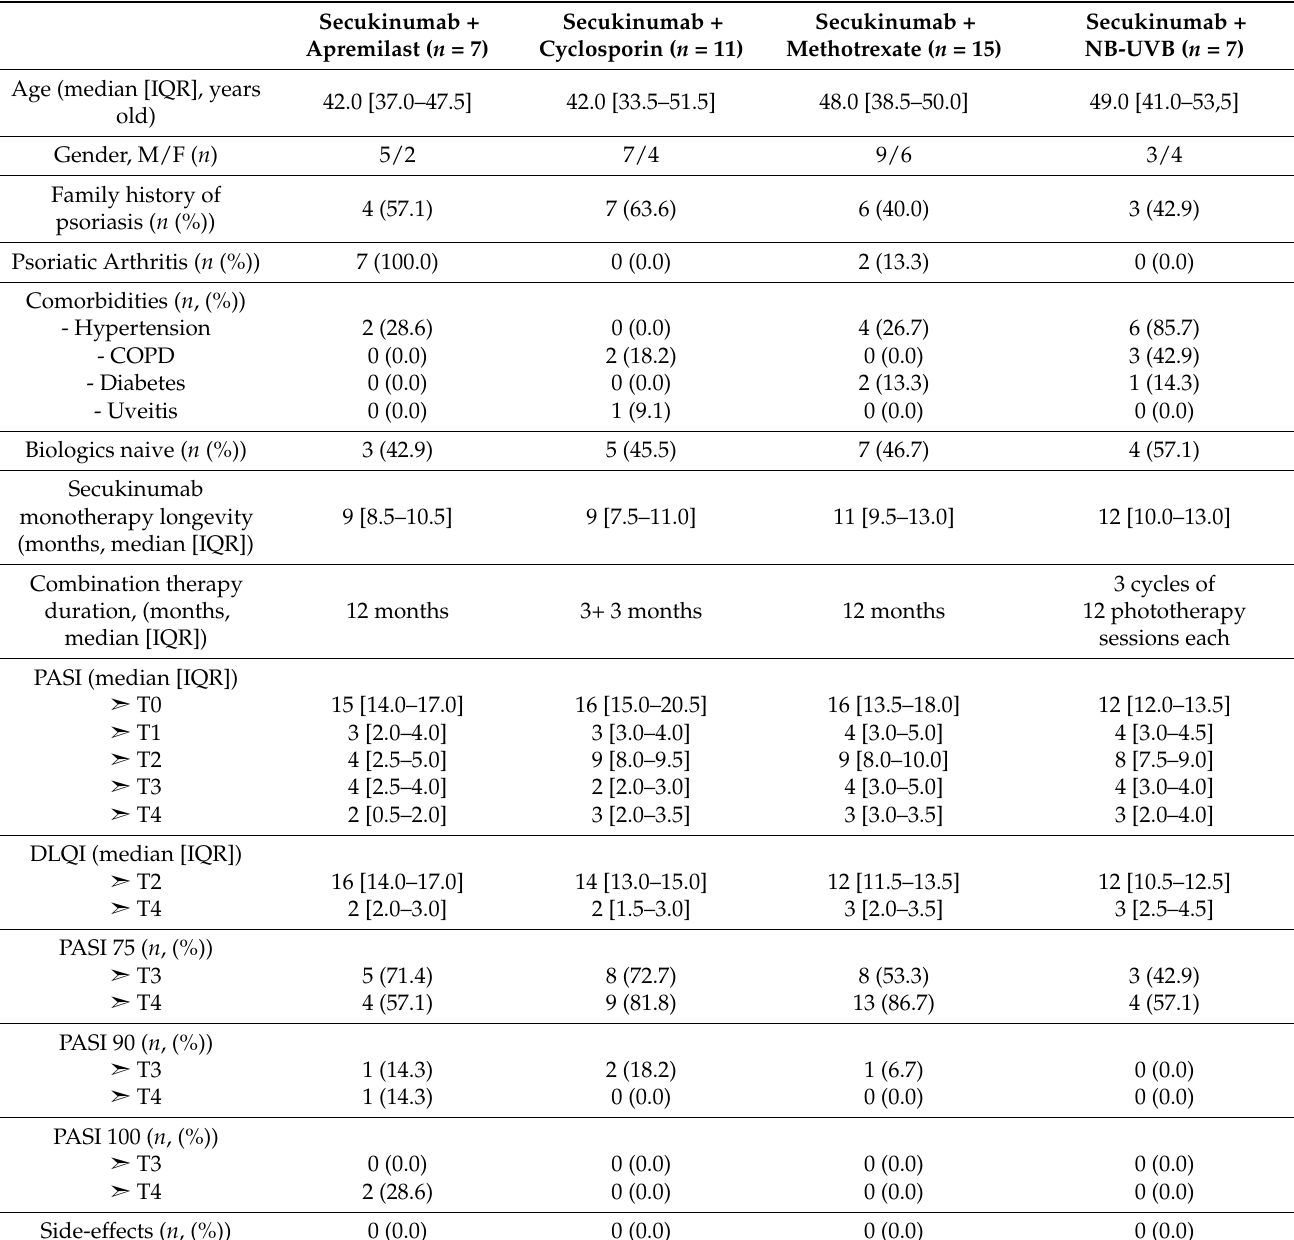
Table 1. Clinical and therapeutic characteristics of the enrolled patients stratified for the combination therapy